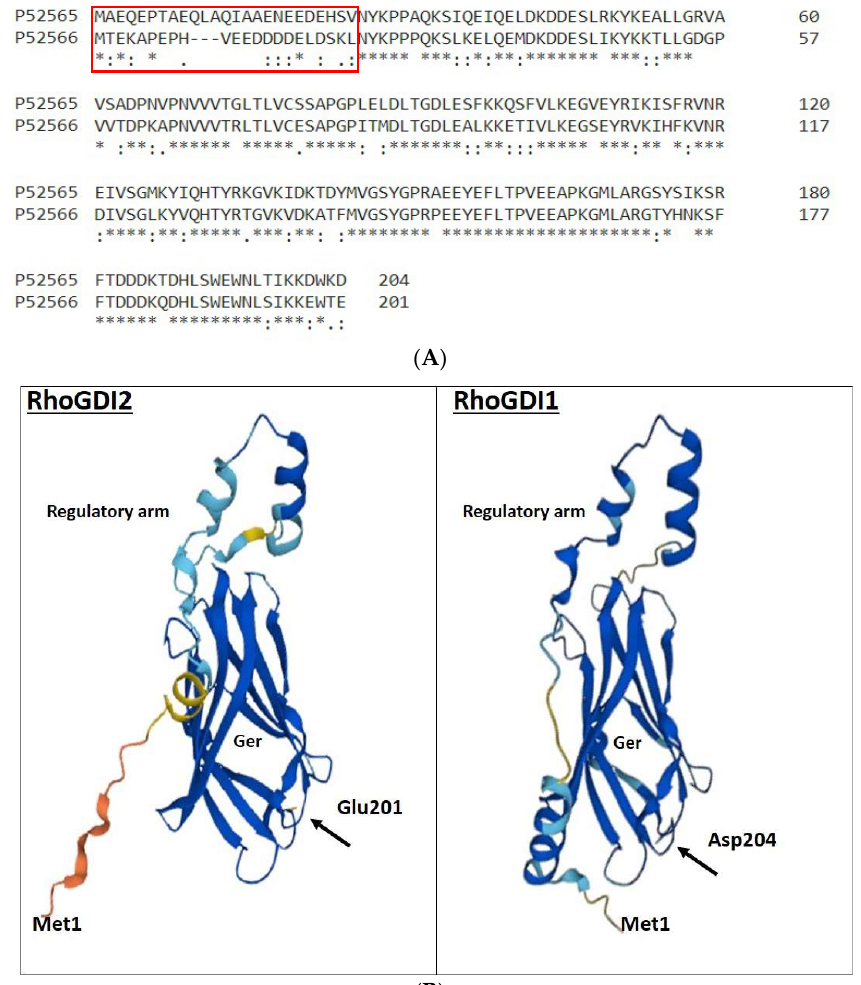
Figure 2. Comparison of primary and tertiary structures of human RhoGDI1 and RhoGDI2. ( A ) Protein sequences were compared using EMBL-EBI’s Clustal Omega tool. The accession numbers are as follows: human RhoGDI1, P52565 and human RhoGDI2, P52566. Identical residues are indicated by asterisks; substitutions for amino acids possessing highly similar or somehow similar characteristics are indicated by double and single dots, respectively. The highly divergent extreme N-terminal domains are enclosed in the red box. RhoGDI2 is phosphorylated at Y24, S31 and Y153 by β 2 integrin-related kinases Src, c-Abl and Syk in response to PSGL-1 antibody ligation. On the contrary, RhoGDI1 is phosphorylated at S45, S48 and T52 by calcium-dependent protein kinase CPK3. ( B ) Predictions of the 3D structure of RhoGDI1 and RhoGDI2 are from the AlphaFold project (AF-P52565-F1 and AF-P52566-F1, respectively). Confidence regarding the 3D structure corresponding to different parts of the proteins is provided by color code, with dark blue representing the highest confidence and orange the lowest confidence. Ger: pocket accommodating the geranylgeranyl moiety of the Rho